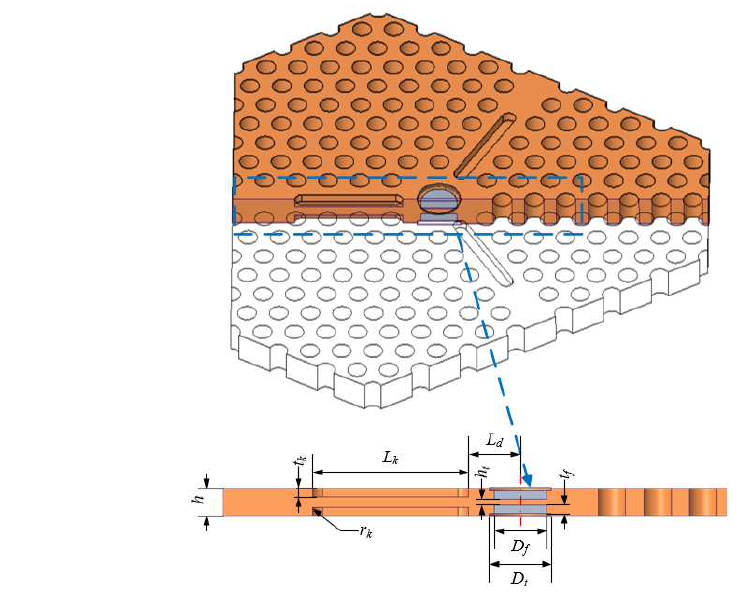
Figure 3. Structure of the designed PC slab circulator with dimensions. ( a ) Three-dimensional view of the PC slab circulator (half wireframe view). ( b ) Partial cross-section view with detailed dimensions (red dashed line is center line of the